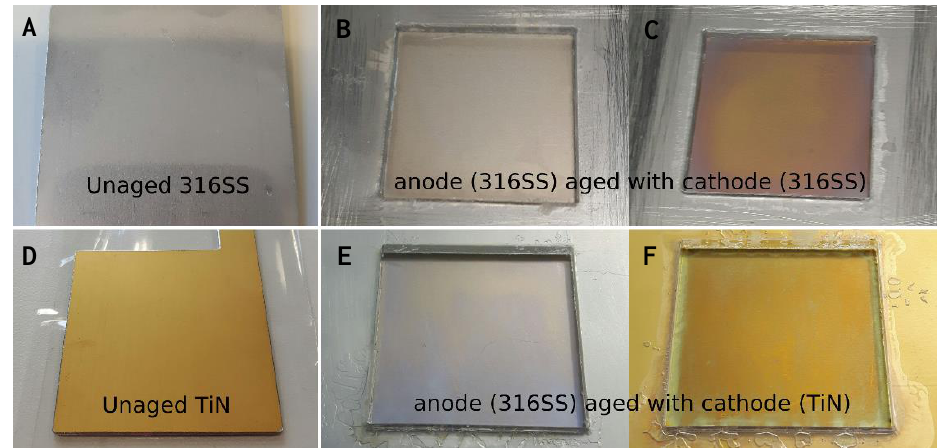
Figure 3. Visual appearance before and after Ageing Protocol A of 316 stainless-steel electrodes both coated in TiN and uncoated. ( A ) is original unaged electrode, ( B ) and ( C ) are the anode and cathode respectively), ( D ) is the unaged TiN coated electrode, ( E ) and ( F ) are the anode and cathode respectively.